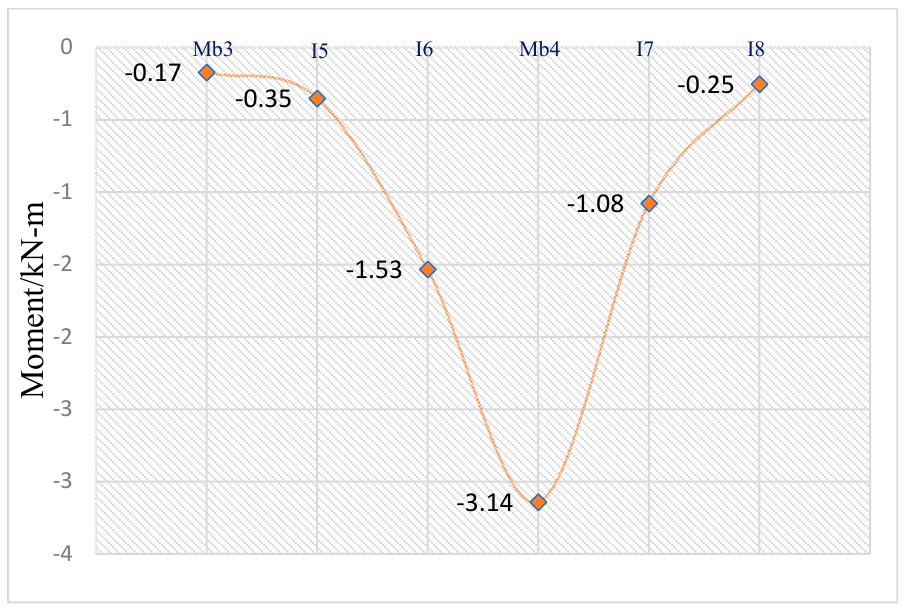
Figure 12. Moment distribution over support C.